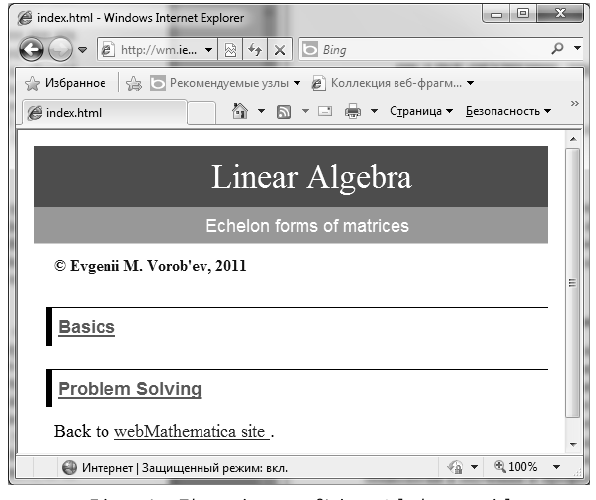
Figure 1. The main page of Linear Algebra tutorial